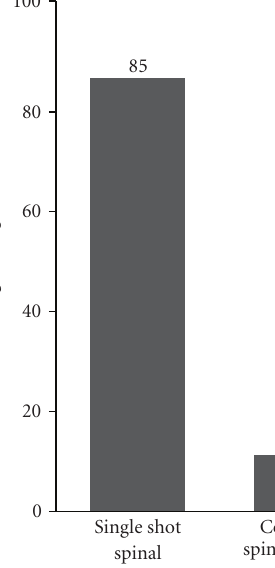
Figure 2: Preferred Regional Technique for Elective Cesarean Delivery.